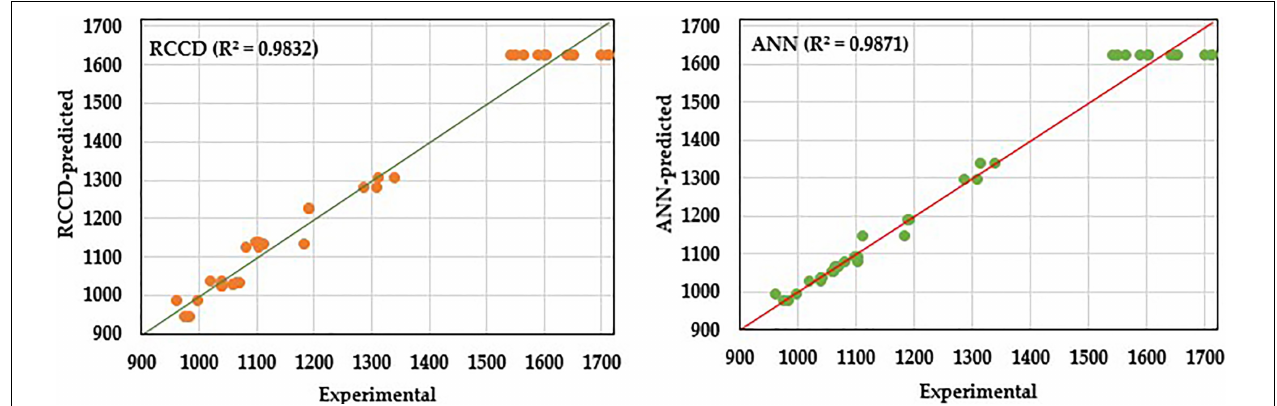
FIGURE 9 | Experimental values against predicted values by RCCD or ANN model for amino acids biosynthesis by B. paramycoides ZW-5.